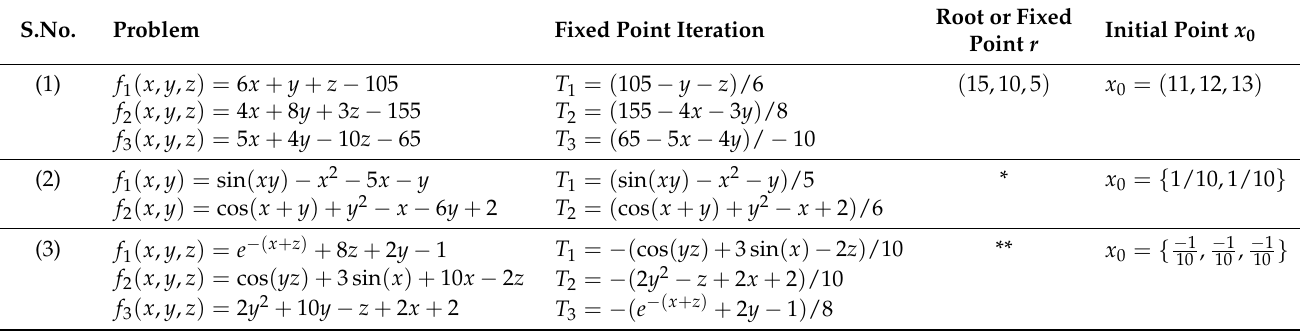
Table 7. Test problem for linear and non-linear system of equations.